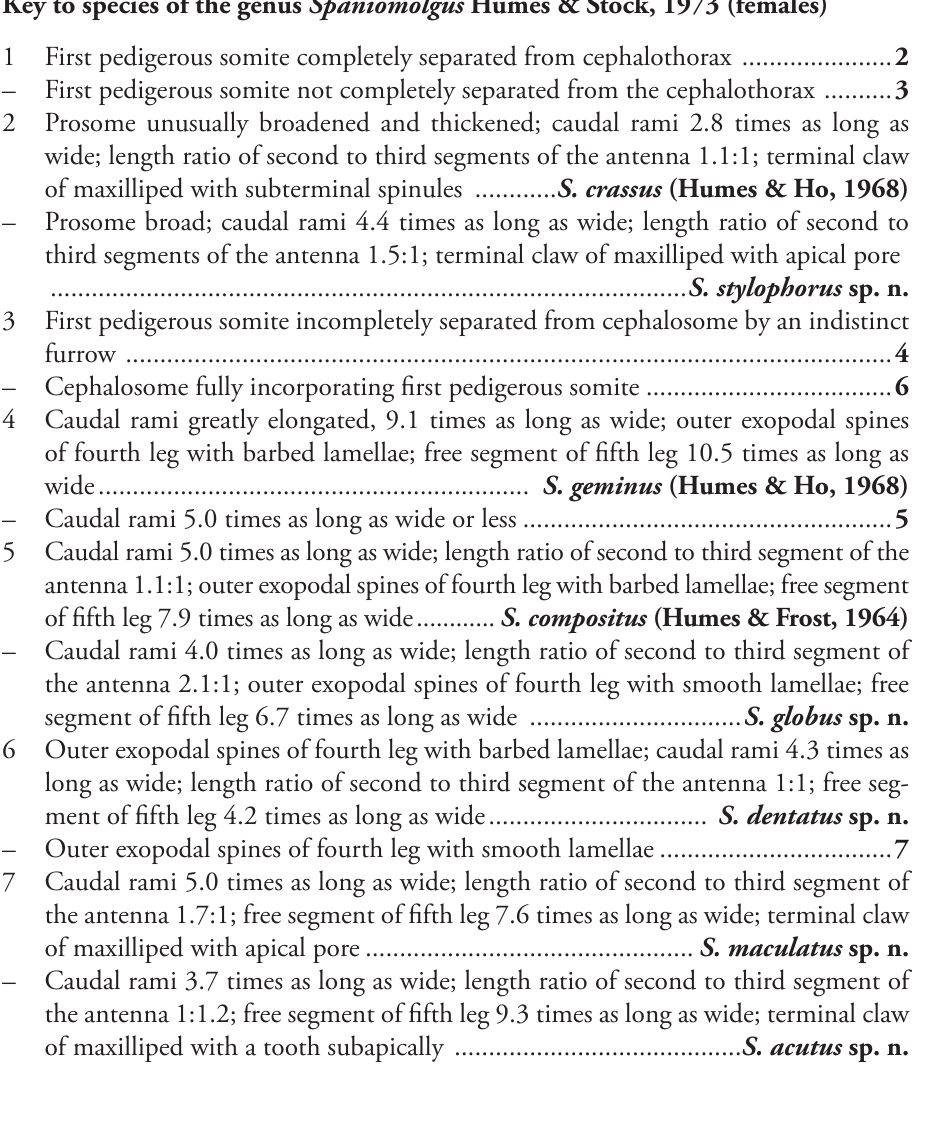
Spaniomolgus compositus found by Humes and Frost (1964) in washings of Stylophora subseriata, and Spaniomolgus crassus and S. geminus reported by Humes and Ho (1968) from washings of Stylophora mordax (Dana, 1846) should be now considered as co- occurring symbionts of one coral host, Stylophora pistillata. We assume that the coral indicated by Humes and Frost (1964) as Seriatopora subseriata is actually Stylophora subseriata (Ehrenberg, 1834) as the name Seriatopora subseriata is not valid. Thus,